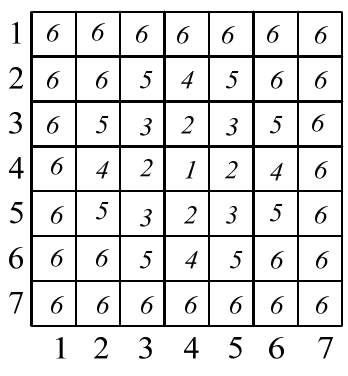
Figure 4. The quantified spot template.